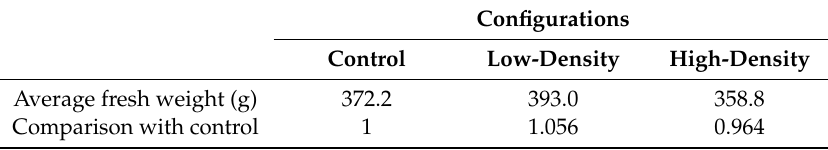
Table 1. Average fresh weight of corn crops grown in di ff erent